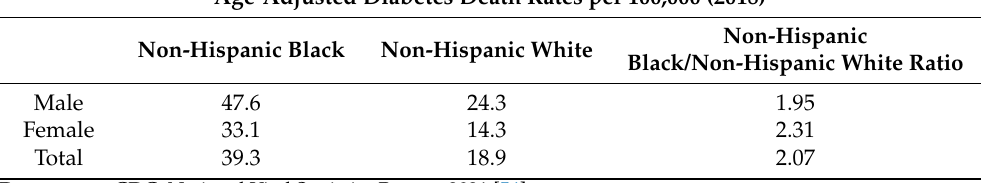
Table 3. Diabetes death rates. Age-Adjusted Diabetes Death Rates per 100,000 (2018) Non-Hispanic